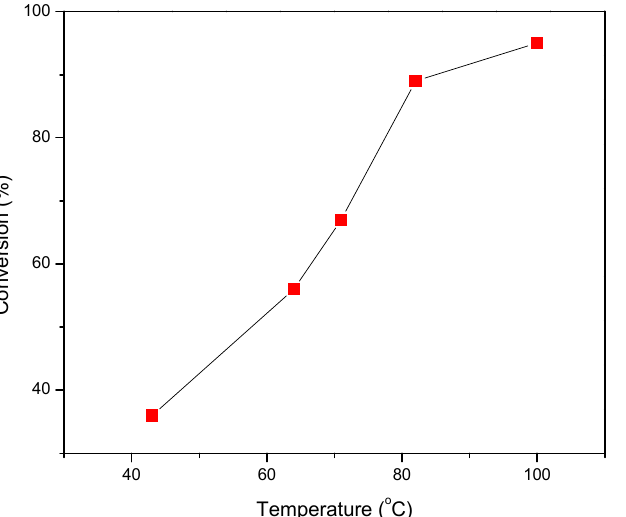
Figure 4. Temperature profile for the total conversion of styrene to its oxygenates catalyzed by complex 3 .